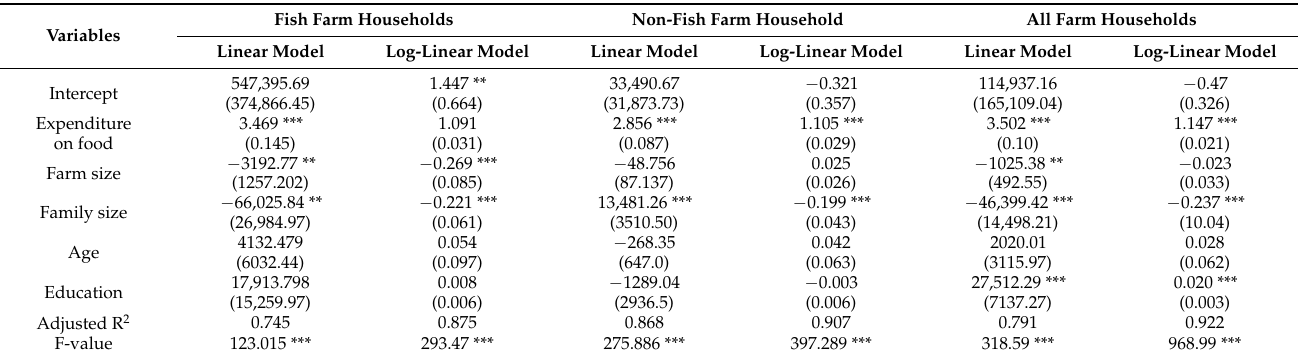
Table 4. Annual expenditure function of farm